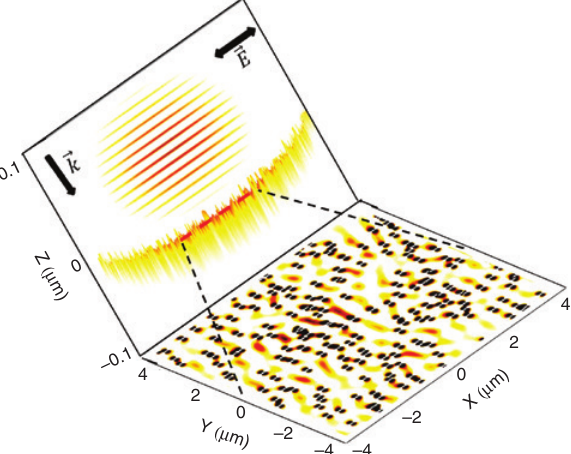
Figure 1. Before analyzing the origin of the complex inter- ference patterns on the metal surface with random sub- wavelength holes, we focus on the individual response of